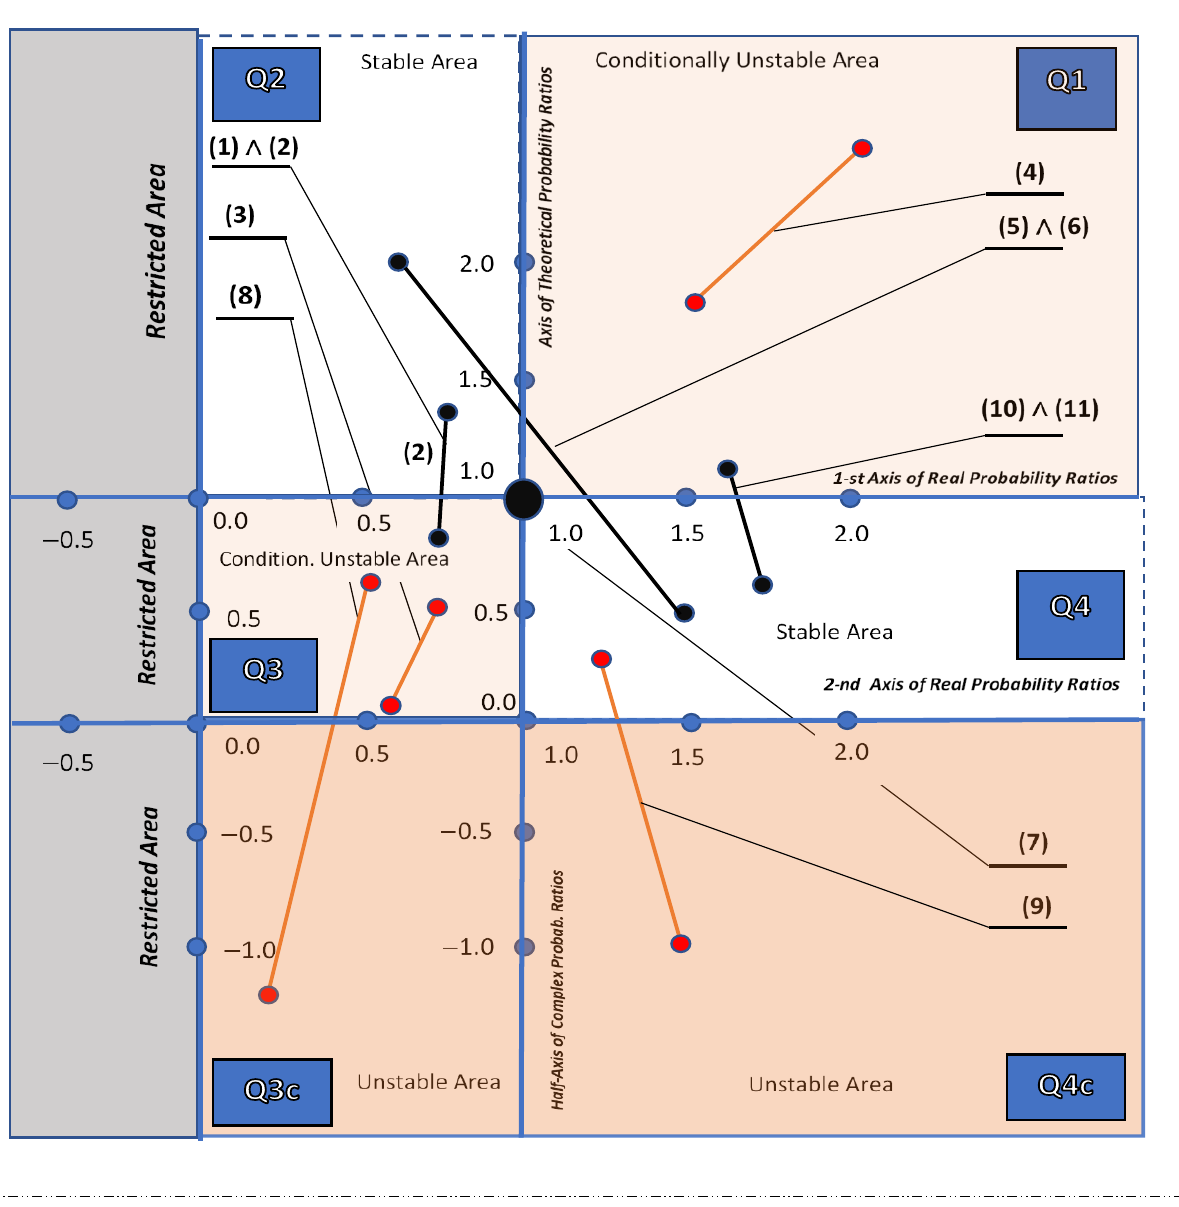
Figure 1. Stability diagram of contingent subgroups with an associated group.